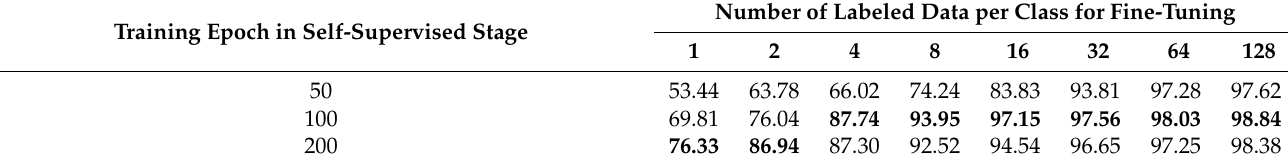
Table 7. The test accuracy (%) of the MsvNetLite with different training epochs for self- supervised learning. The bold number is the best result in each column.